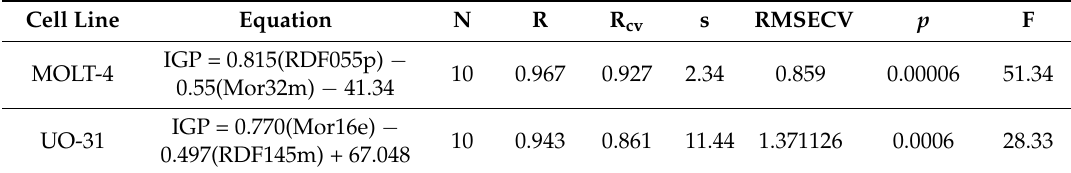
Table 2. Developed QSAR models and their performance in predicting anticancer activity of 3-amino-6-chloro-7-(azol-2 or 5-yl)-1,1-dioxo-1,4,2-benzodithiazine derivatives 5a – j against MOLT-4 and UO-31 cell lines.